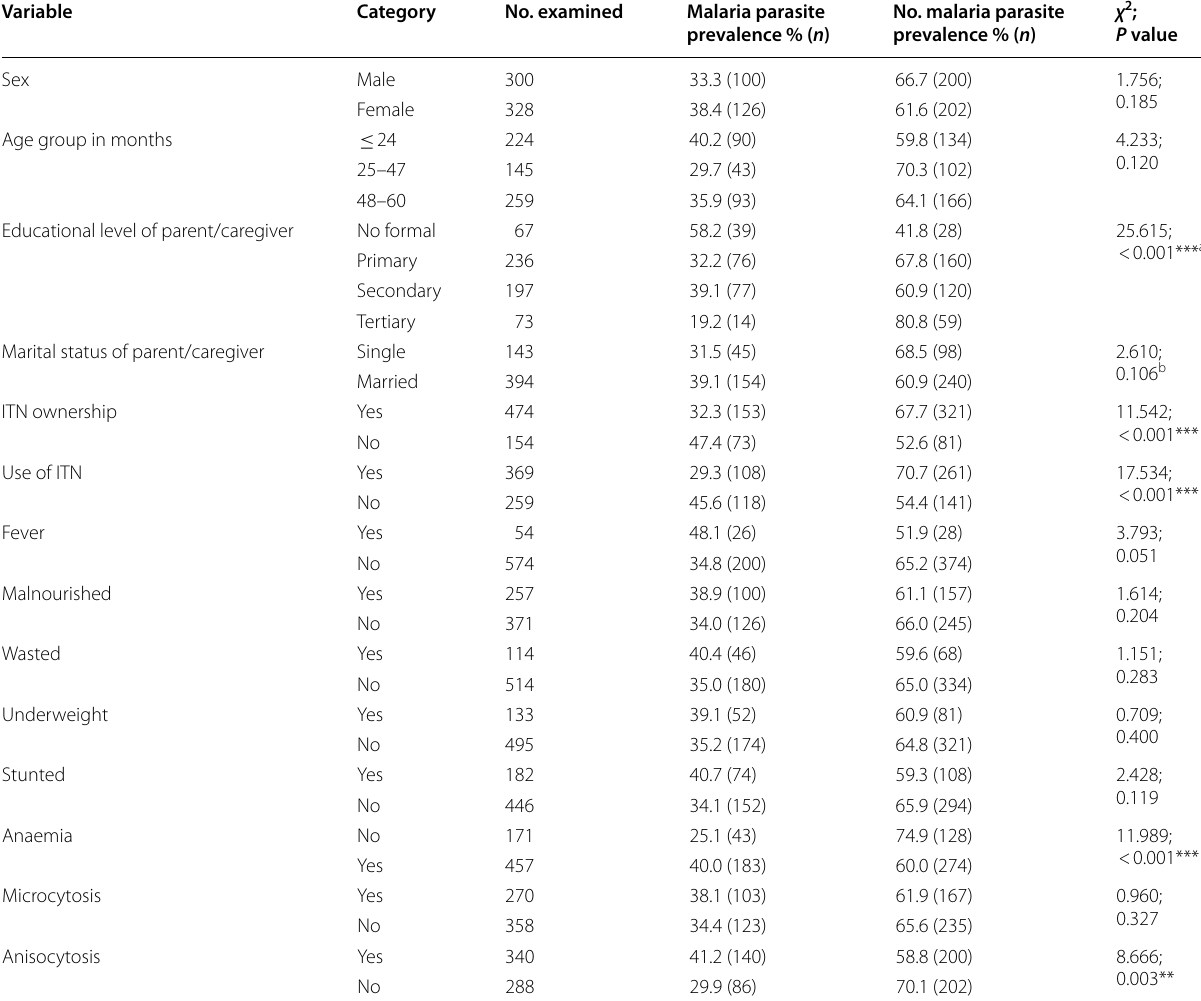
a Educational level of parent/caregiver was evaluated for 573 participants b Marital status of parent/caregiver was evaluated for 537 participant **Statistically significant at P < 0.01; ***Statistically significant at P <